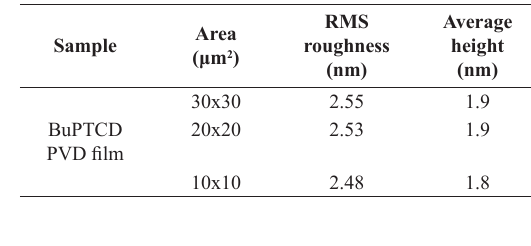
Table 1. roughness (RMS) and average height for 100 nm PVD film of